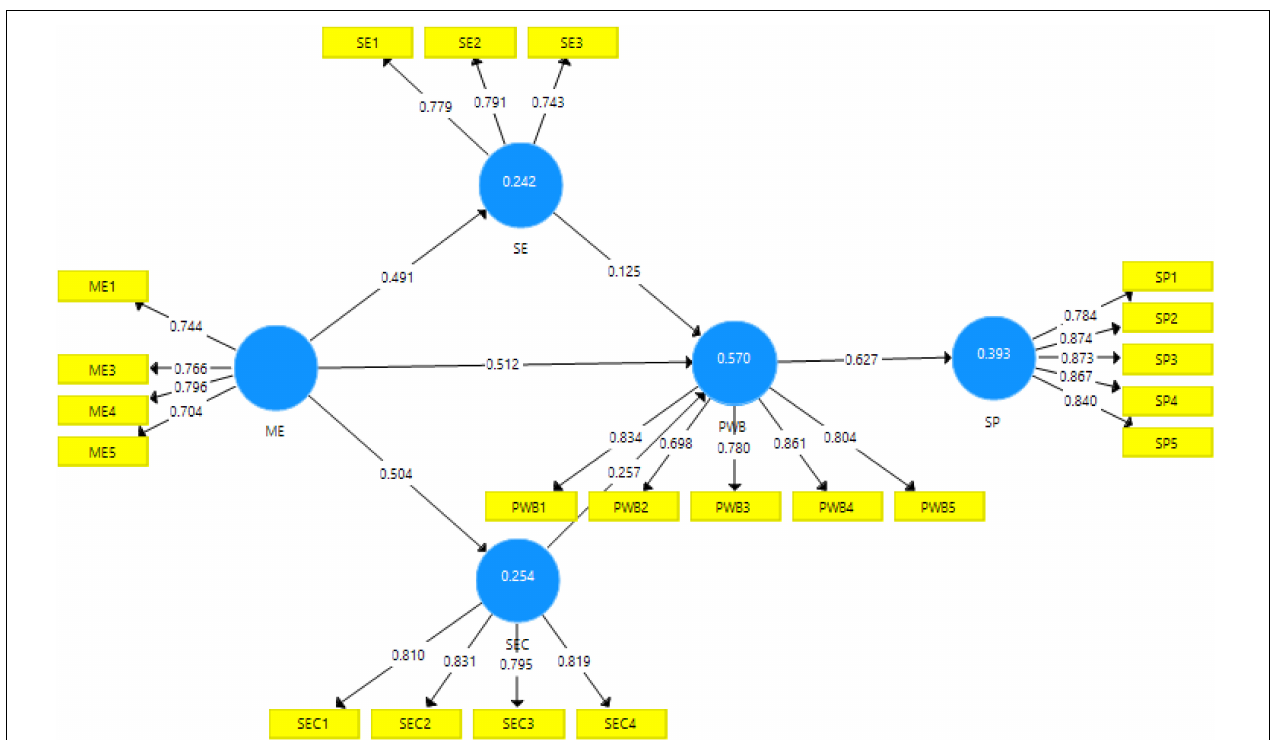
FIGURE 2 | Output of measurement model